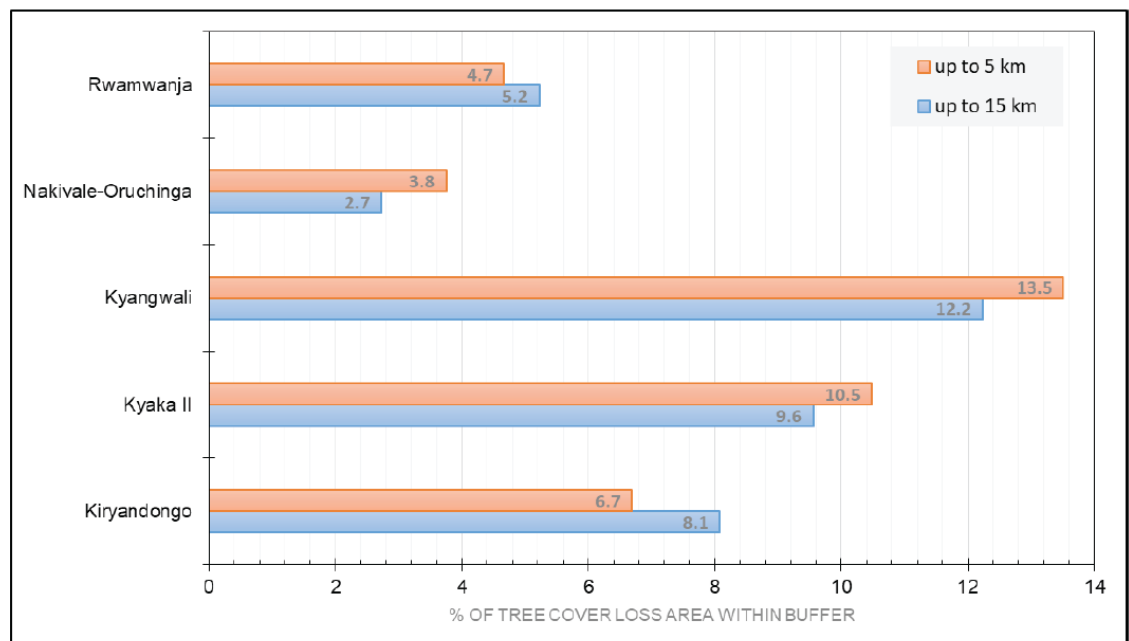
Figure 8. Summary of tree cover loss from across buffers in the AoIs (2001–2018) in western and southwestern Uganda. Source: Tree cover loss: Hansen et al. 2013 [22].